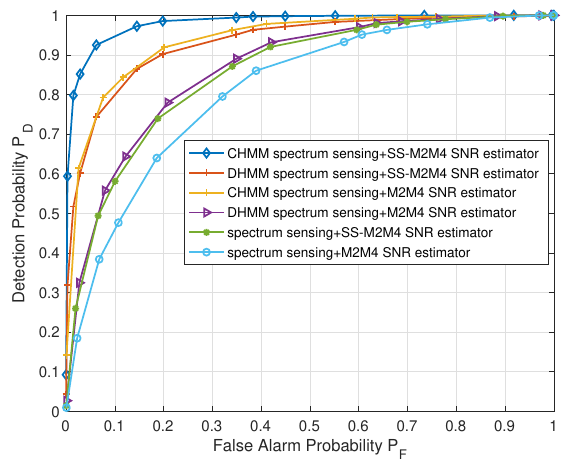
Figure 9. Detection probability versus false alarm probability.